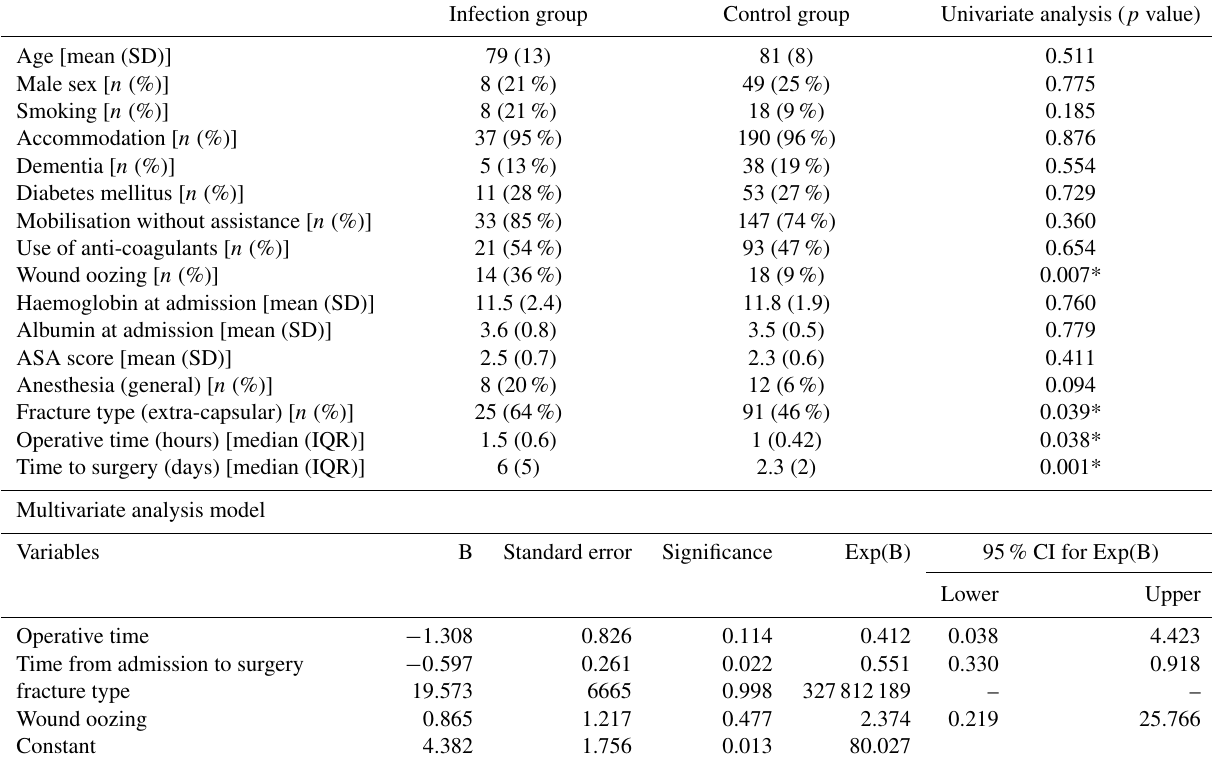
Table 5. Comparison different pre-operative, operative and postoperative factors between infection and control group that used for the logistic regression model to explore if any of them predisposed to